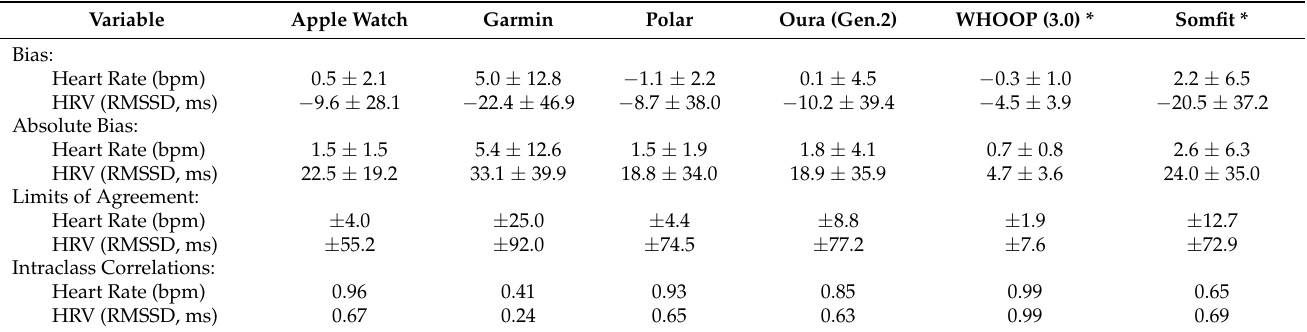
Note: Shaded grey cells indicate PSG sleep states were correctly identified by the wearable device. Table 6. Biases, limits of agreement and correlations between ECG and each device for heart rate and heart rate variability (HRV). Biases data are mean ± SD.